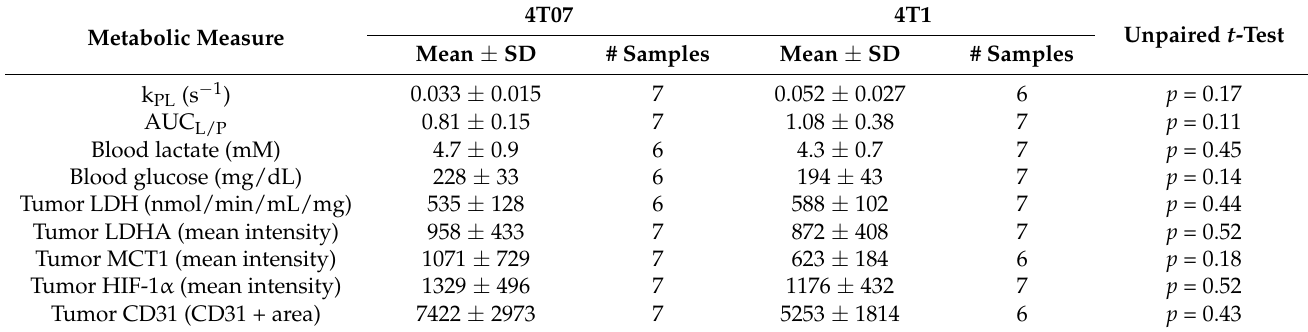
Figure 1. Comparison of immunohistochemistry results between 4T07 and 4T1 tumors: ( a ) LDHA; ( b ) MCT1 transporter; ( c ) HIF-1 α ; ( d ) and presence of endothelial cells via CD31. Error bars represent the median, 25th , and 75th percentiles. Table 2. Statistical results comparing imaging, biochemical, and immunohistochemical metabolic measures between 4T07 and 4T1 tumor models.